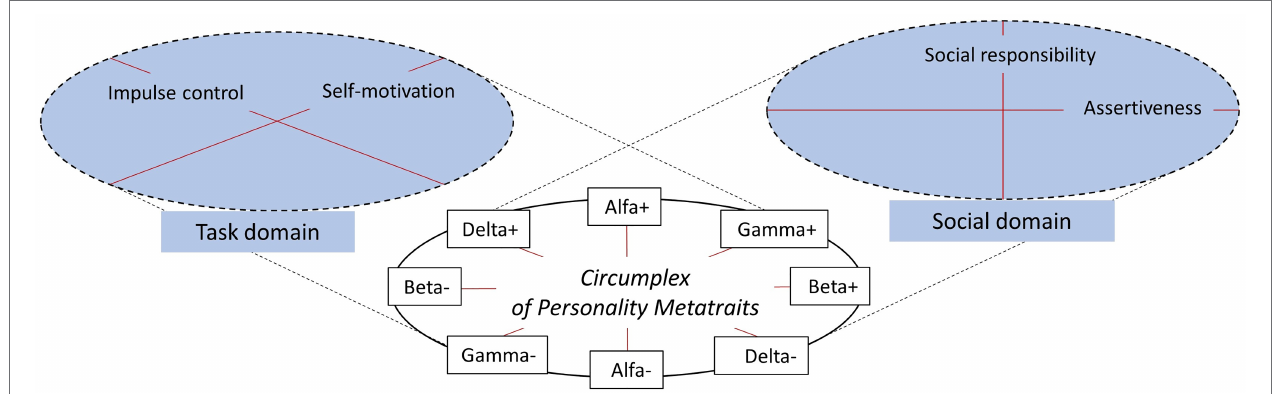
FIGURE 4 | Personality competencies within the Circumplex of Personality